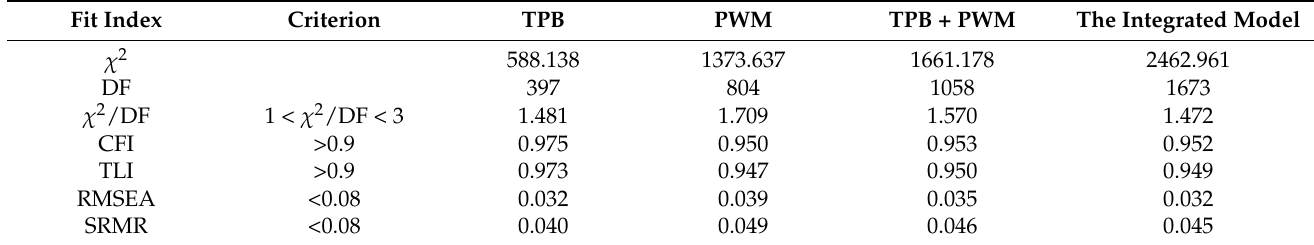
Table 3. The goodness-of-fit